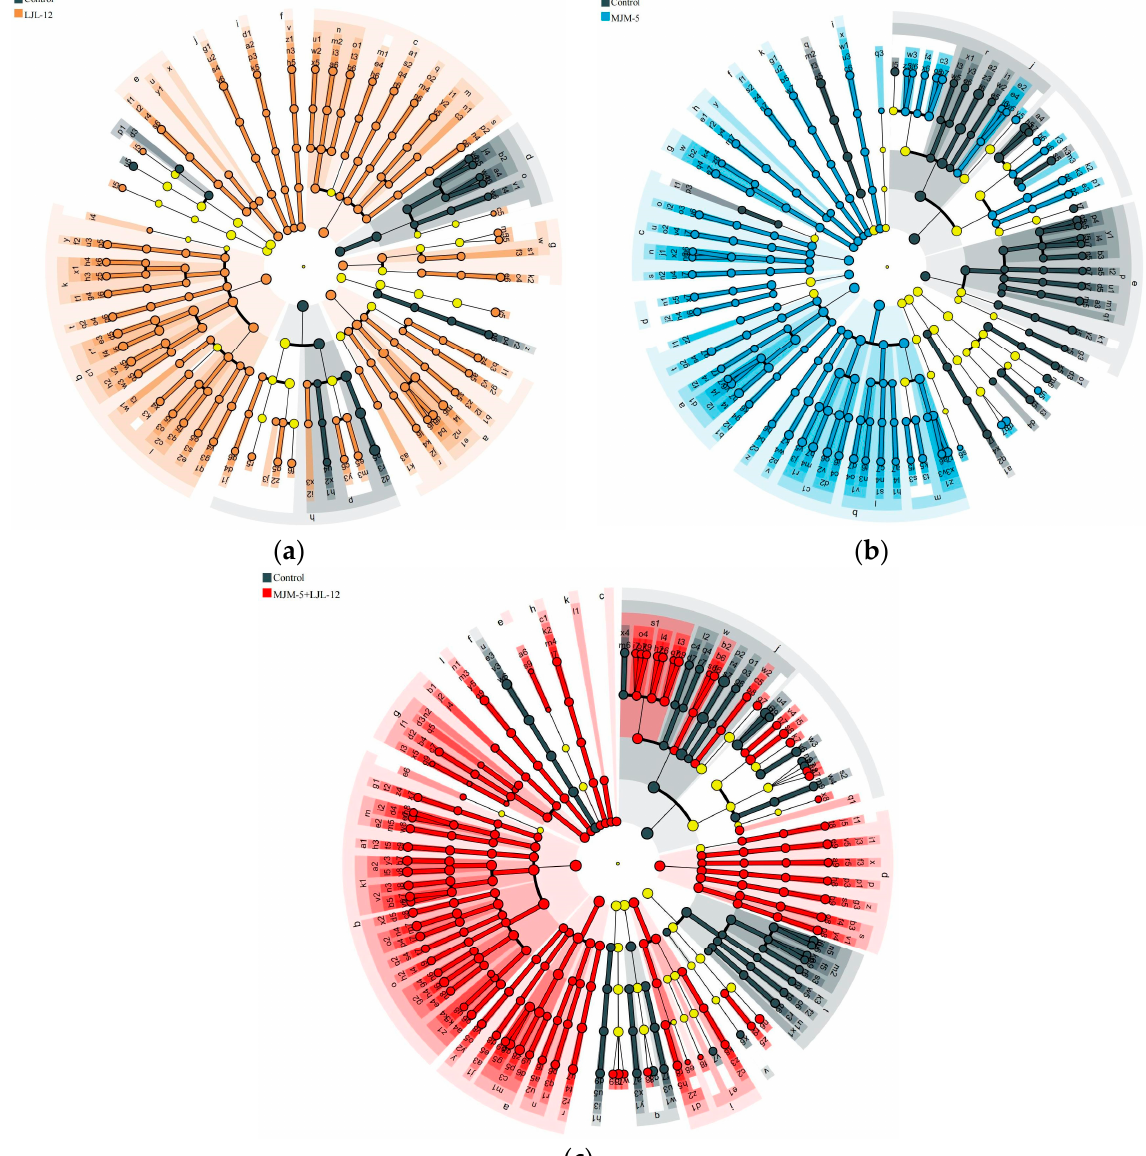
Figure 6. Key bacterial taxa of alfalfa rhizosphere soil under different treatments: ( a ) Control and LJL-12 treatments; ( b ) Control and MJM-5 treatments; ( c ) Control and MJM-5+LJL-12 treatments. LEfSe analysis depicting differentially abundant taxa as biomarkers using the Kruskal–Wallis test with an LDA score ˃ 3.0. The circles from the inside to the outside indicate bacterial taxonomic levels from phylum to genus. The colored circles corresponding to different treatment groups in the figure represent the key bacterial taxa that were significantly enriched under that treatment group, and the bacterial taxa that were significantly enriched under different inoculation treatment are detailed in Supplementary Tables S6–S8.